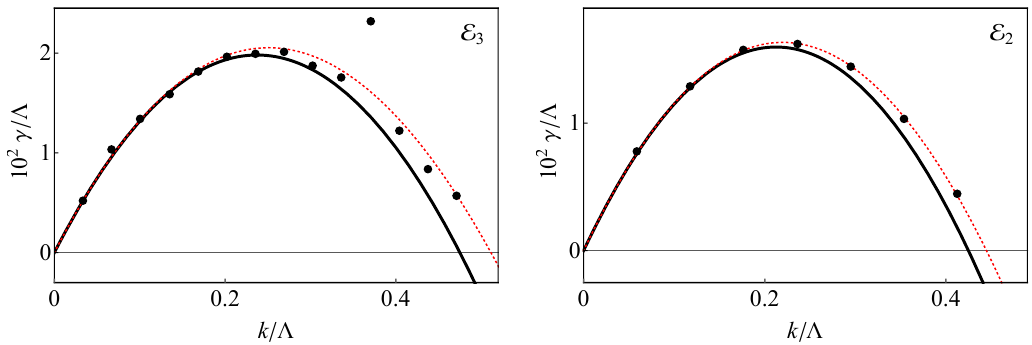
Figure 7 . The continuous black curves show the growth rates predicted by the linear approxima- tion (2.14) to order k 2 for the energies corresponding to the evolutions shown in (cid:12)gure 4. The black dots show the growth rates extracted from a (cid:12)t to the slopes in (cid:12)gures 5 and 6. The dotted red curves corresponds to a (cid:12)t to the expression (2.10), with the result (3.3). by the sound mode to a new growth rate given by a resonance. As these may change in time, we have obtained the dots of (cid:12)gure 7 from early times, when the resonant behaviors are